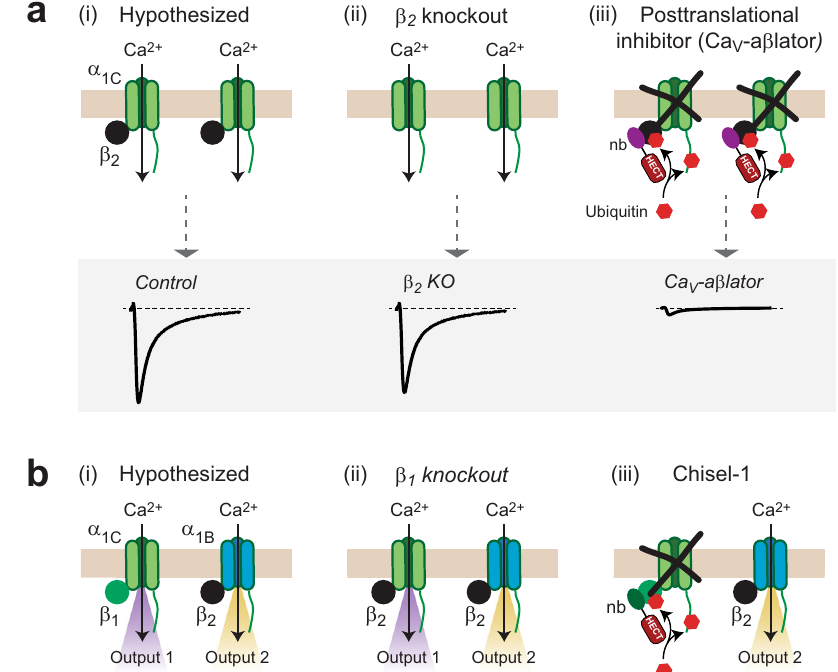
Fig. 1 | Rationale for developing post-translational Ca V β -dependent inhibitors for Ca V 1/Ca V 2 channels. a Cartoon depicting hypothesized association of Ca V 1.2 with β 2b subunitsinadultventricularmyocytes(i)andtheexpectedlossof β 2b with gene knockout of this subunit (ii). Bottom, knock out of β 2 in adult heart has only minimal impact on whole-cell Ca 2+ current making it ambiguous whether most Ca V 1.2 are associated with β 2b in adult ventricular cardiomyocytes. Posttransla-